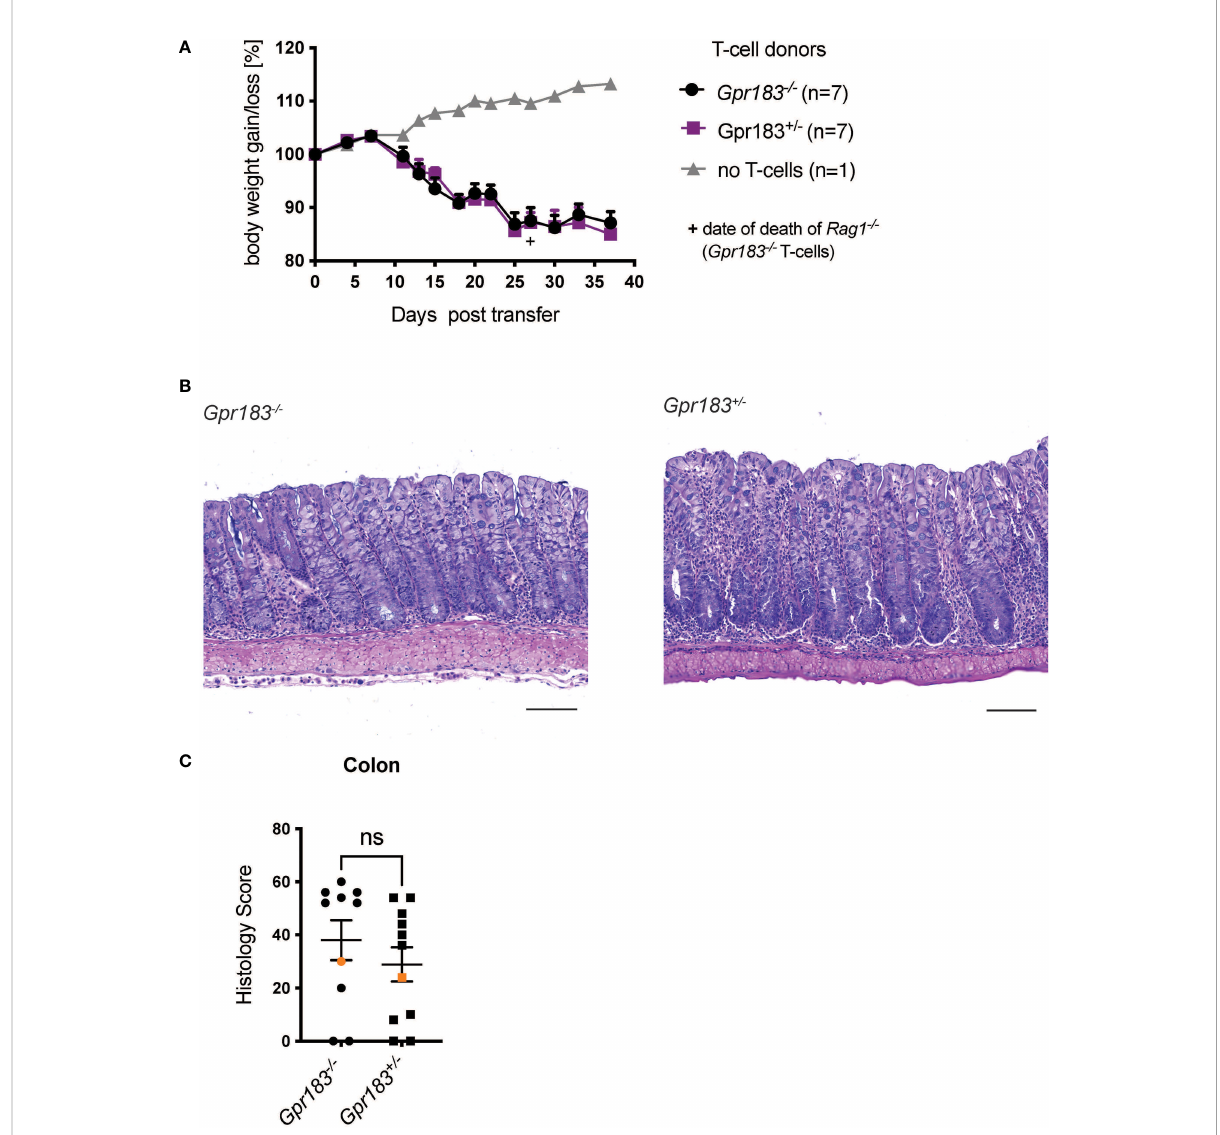
FIGURE 1 T cell expression of GPR183 does not play a role in the transfer colitis model. Colitis was induced by adoptive transfer of GPR183 de fi cient ( Gpr183 -/- ) vs. littermate control ( Gpr183 +/- ) naive CD4 + T cells into Rag1 -/- recipients. (A) Weight change as % starting body weight was monitored on the indicated days. A representative weight graph from one of 2 independent experiments is shown. The weight of dead mice was carried forward, the date of death indicated with a + sign for one mouse for Gpr183 -/- T cells. (B) H&E staining of representative colon sections (middle part of whole colon) at 40x (scale bar 100 m m) magni fi cation (C) Blinded histology score from the middle part of whole colon of combined from the 2 independent experiments. Representative images in (B) were taken from mice represented by the orange colored data points. Error bars represent S.E.M. Two-way ANOVA (Tukey ’ s test) (A) and nonparametric T-test (Mann-Whitney test) (C) . ns, not signi fi